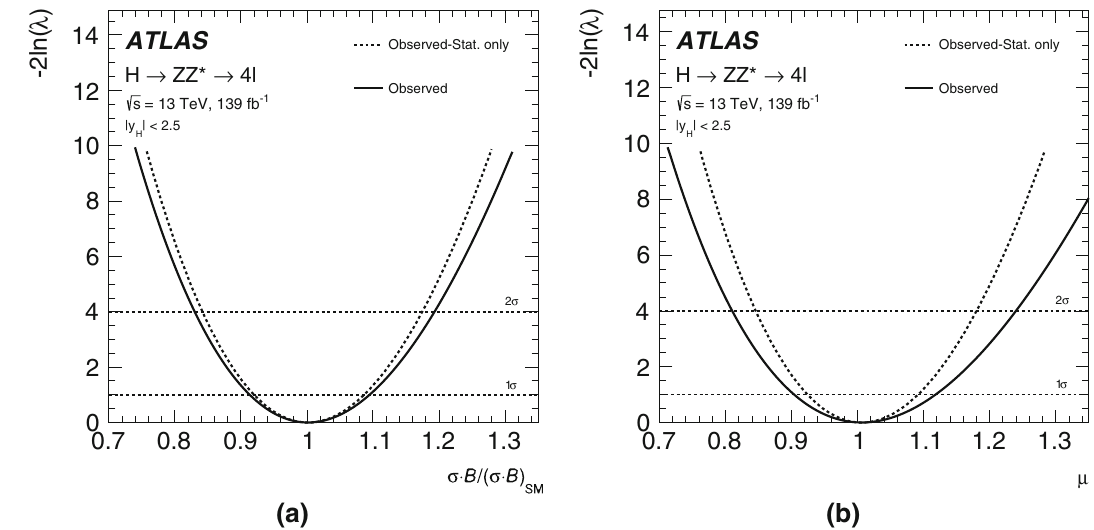
Fig. 9 Observed profile likelihood as a function of ( a ) σ · B ( H → Z Z ∗ ) normalised by the SM expectation and ( b ) the inclusive signal strength μ ; the scans are shown both with (solid line) and without (dashed line) systematic uncertainties Table 8 The expected SM cross-section (σ · B ) SM , the observed value of σ · B , and their ratio (σ · B )/(σ · B ) SM for the inclusive production and for each Production Mode Stage and Reduced Stage-1.1 production bin for the H → Z Z ∗ decay for an integrated luminosity of 139 fb − 1 √ at s = 13 TeV. The bbH ( tH ) contribution is included in the ggF ( ttH )productionbins.Theuncertaintiesaregivenas(stat.)+(exp.)+(th.)